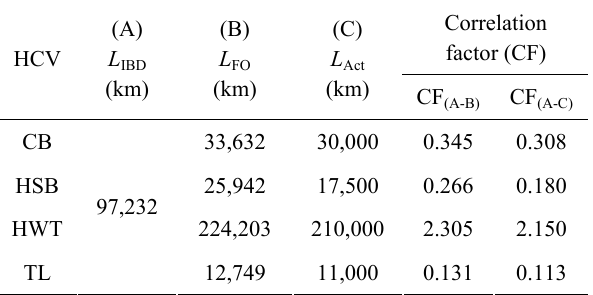
Table 3 Correlation factor based on actual life ( L Act ) and life based on field observation ( L FO ) vs predicted life through IBD ( L IBD ).